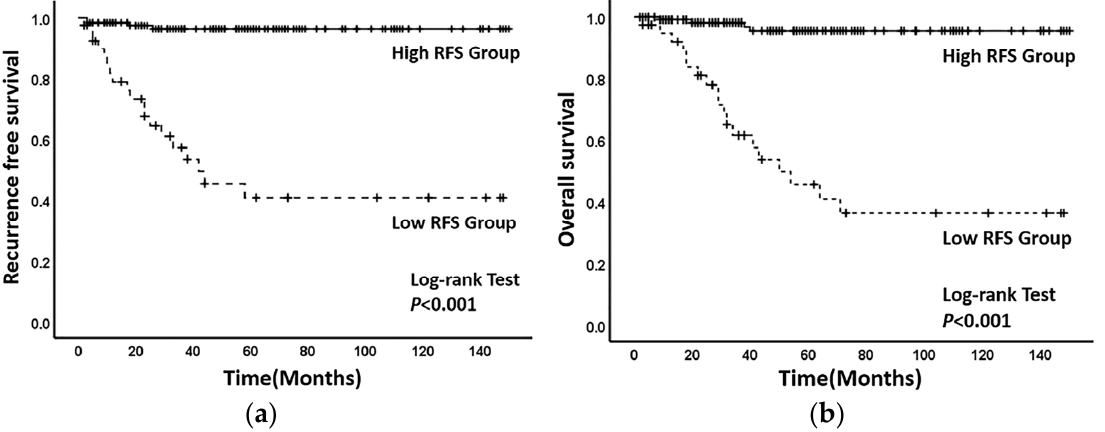
Figure 4. ( a ) Kaplan–Meier survival curves of recurrence-free survival between the low-RFS group and the high-RFS group. ( b ) Kaplan–Meier survival curves of overall survival between the low-RFS group and the high-RFS group. (( a ) Solid line: the recurrence-free survival curve of the high-RFS group. Dotted line: the recurrence-free survival of the curve of the low-RFS group. ( b ) The solid line: The overall survival curve of the high-RFS group. The dotted line: The overall survival of curve the low-RFS